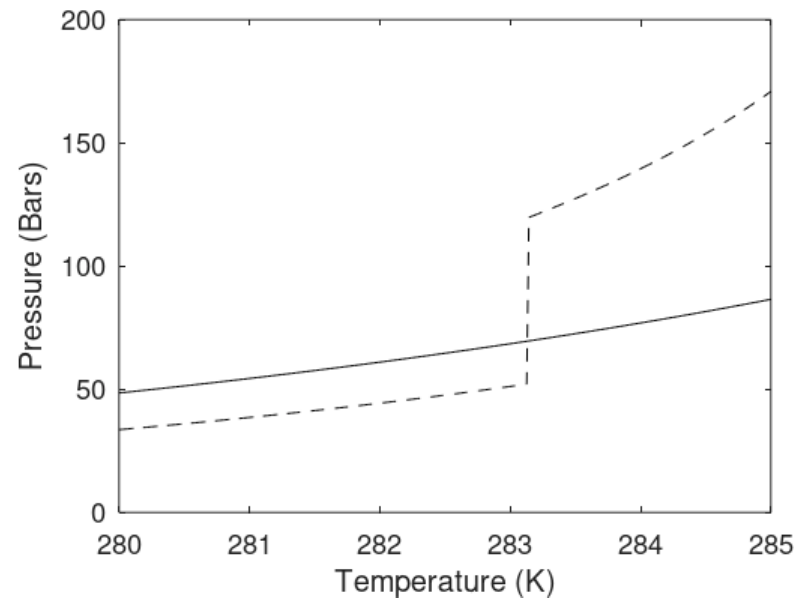
Figure 25. Pressure temperature projection of stability limits for heterogeneous hydrates of CH 4 (solid) and CO 2 (dashed).